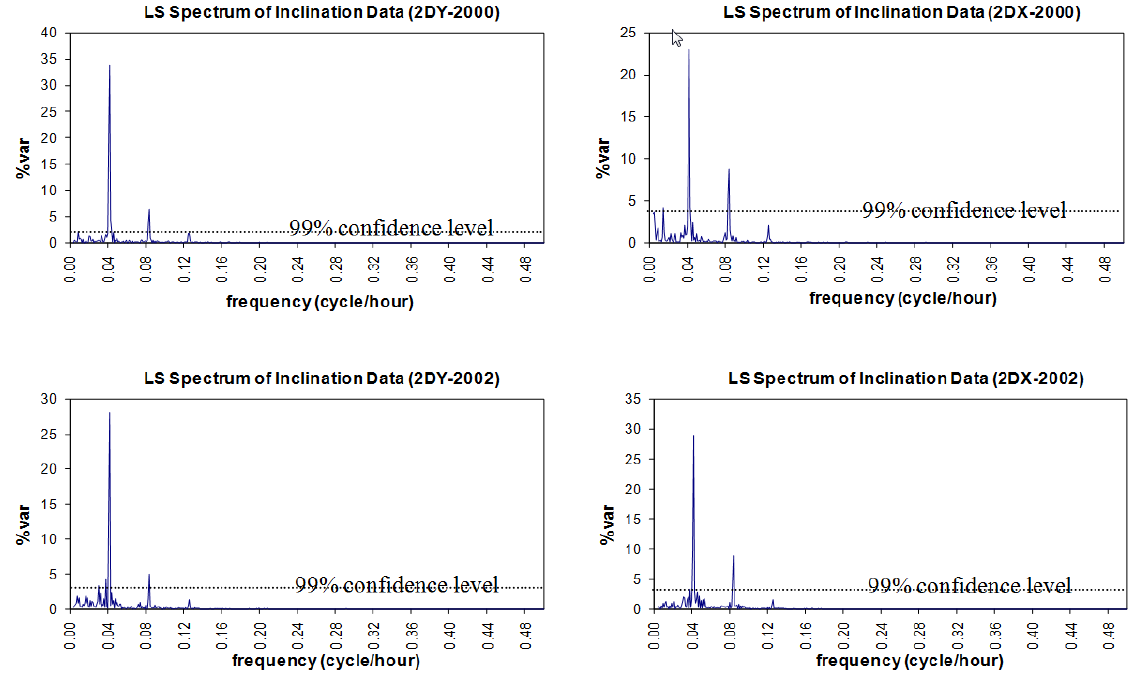
Figure 13. LS spectrum of inclination data of Sensor II mounted on the pillar . Campaign 2000-axis Y (2DY-2000) and axis X (2DX-2000). Campaign 2002-axis Y (2DY-2002) and axis X